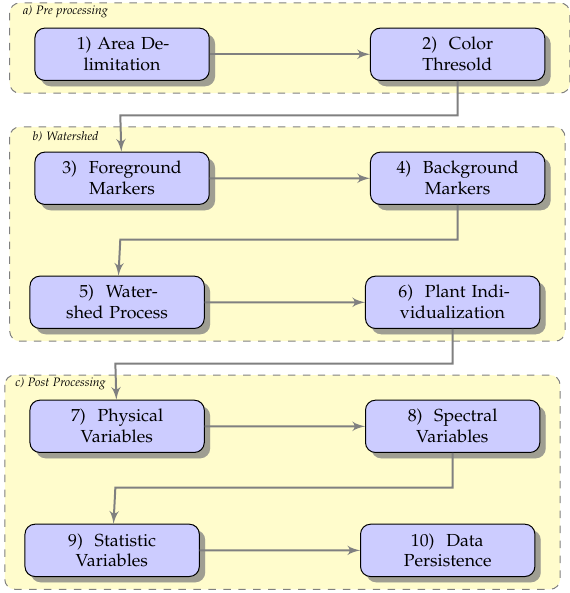
Figure 8. Tree individualization process: it involves the pre-processing of the image, the application of the watershed algorithm for segmentation, and the obtaining of variables and characteristics.